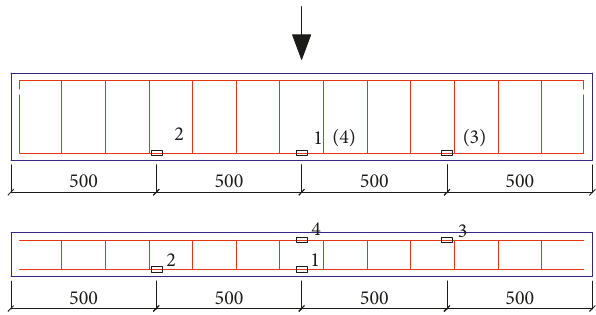
Figure 7: Distribution of the steel strain gauge.